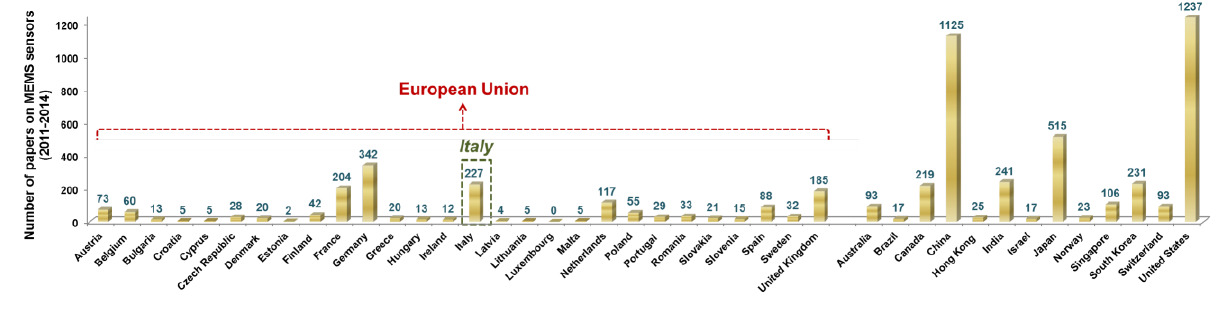
Figure 4. Number of research papers published in the period 2011–2014 on MEMS sensors. The analysis was conducted for all the EU member states and for other countries with relatively high income and technological development level. Source: Scopus, searching the word “MEMS sensor” in title, abstract and keywords for journal papers